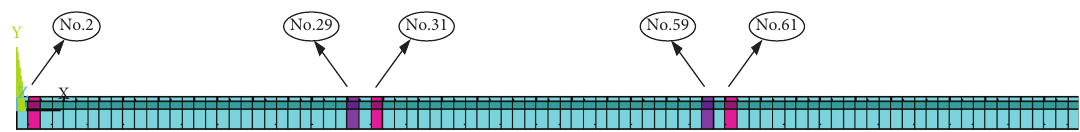
Figure 20: Damage location of three-span continuous girder. Table 5: Damage cases of continuous